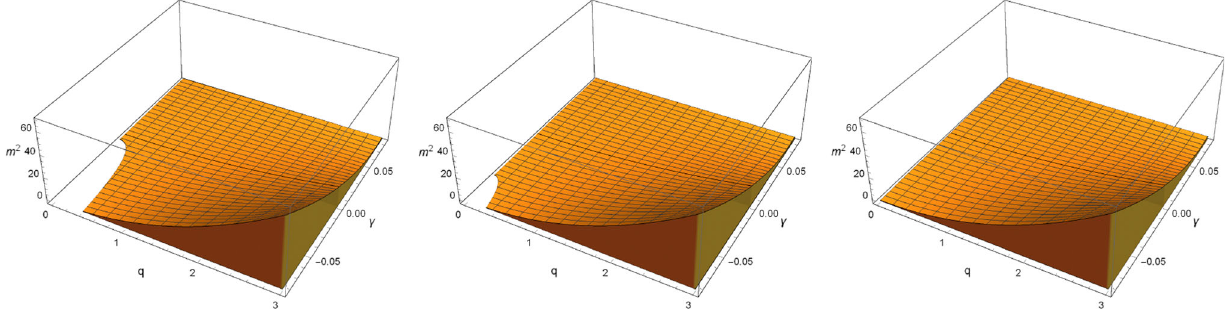
Fig. 7 3D plot of the allowed region for the superconducting phase transition at the zero temperature for a fixed α 1 (from left to right, α 1 = − 0 . 5 , 0 , 0 . 5)